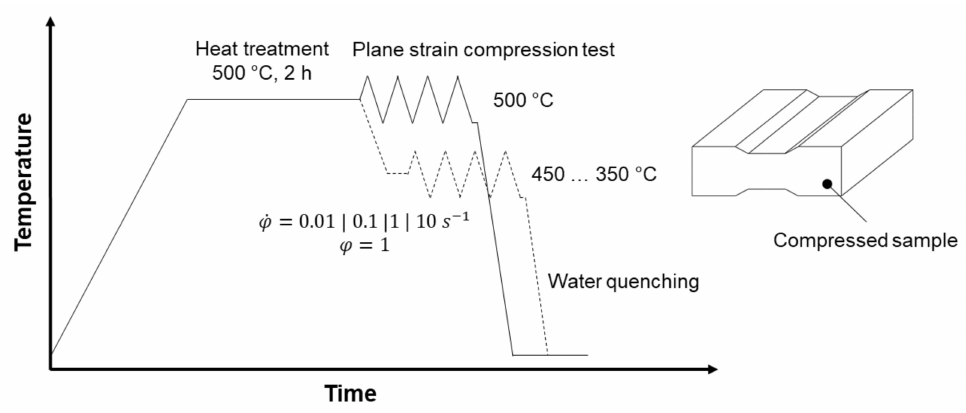
Figure 1. Schematic diagram of plane strain compression